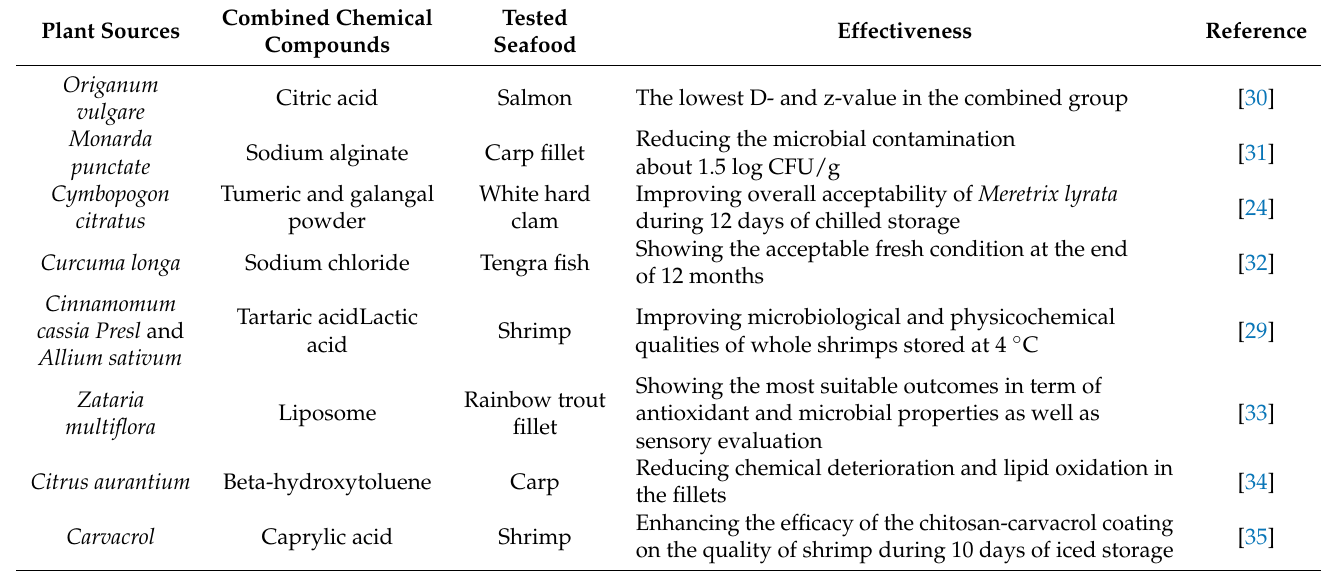
Table 1. Synergistic or additive effect of essential oils combined with other chemical substances on quality retention of seafood